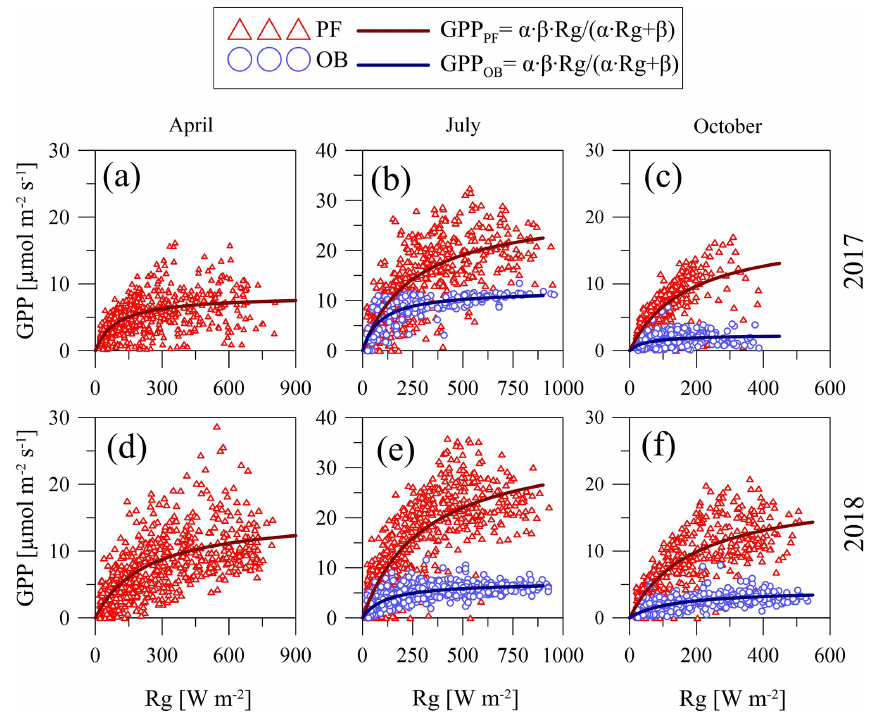
Figure 6. Hyperbolic light response curves (Eq. 3) of gross primary production (GPP) for April (a, d) , July (b, e) , and October (c, f) in 2017 and 2018 at the paludified forest (PF) and ombrotrophic bog (OB) sites.